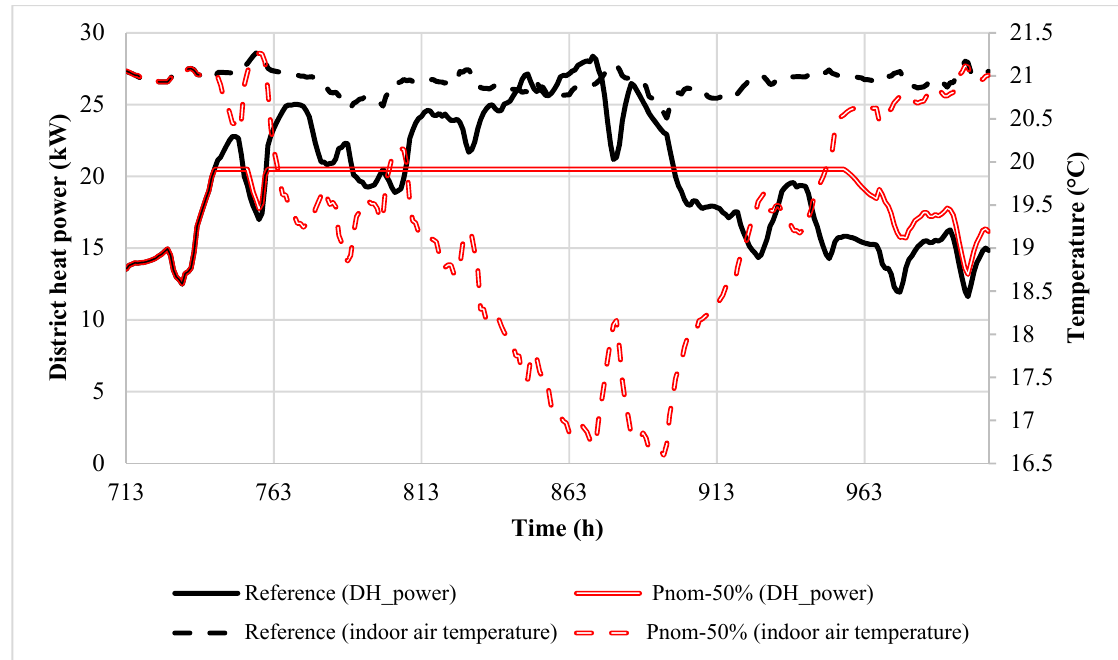
Figure 12. Peak power demand-limiting effect on indoor temperature of the coldest room (namely, office room 8) and power usage for the Pnom-50% case compared with the reference case.